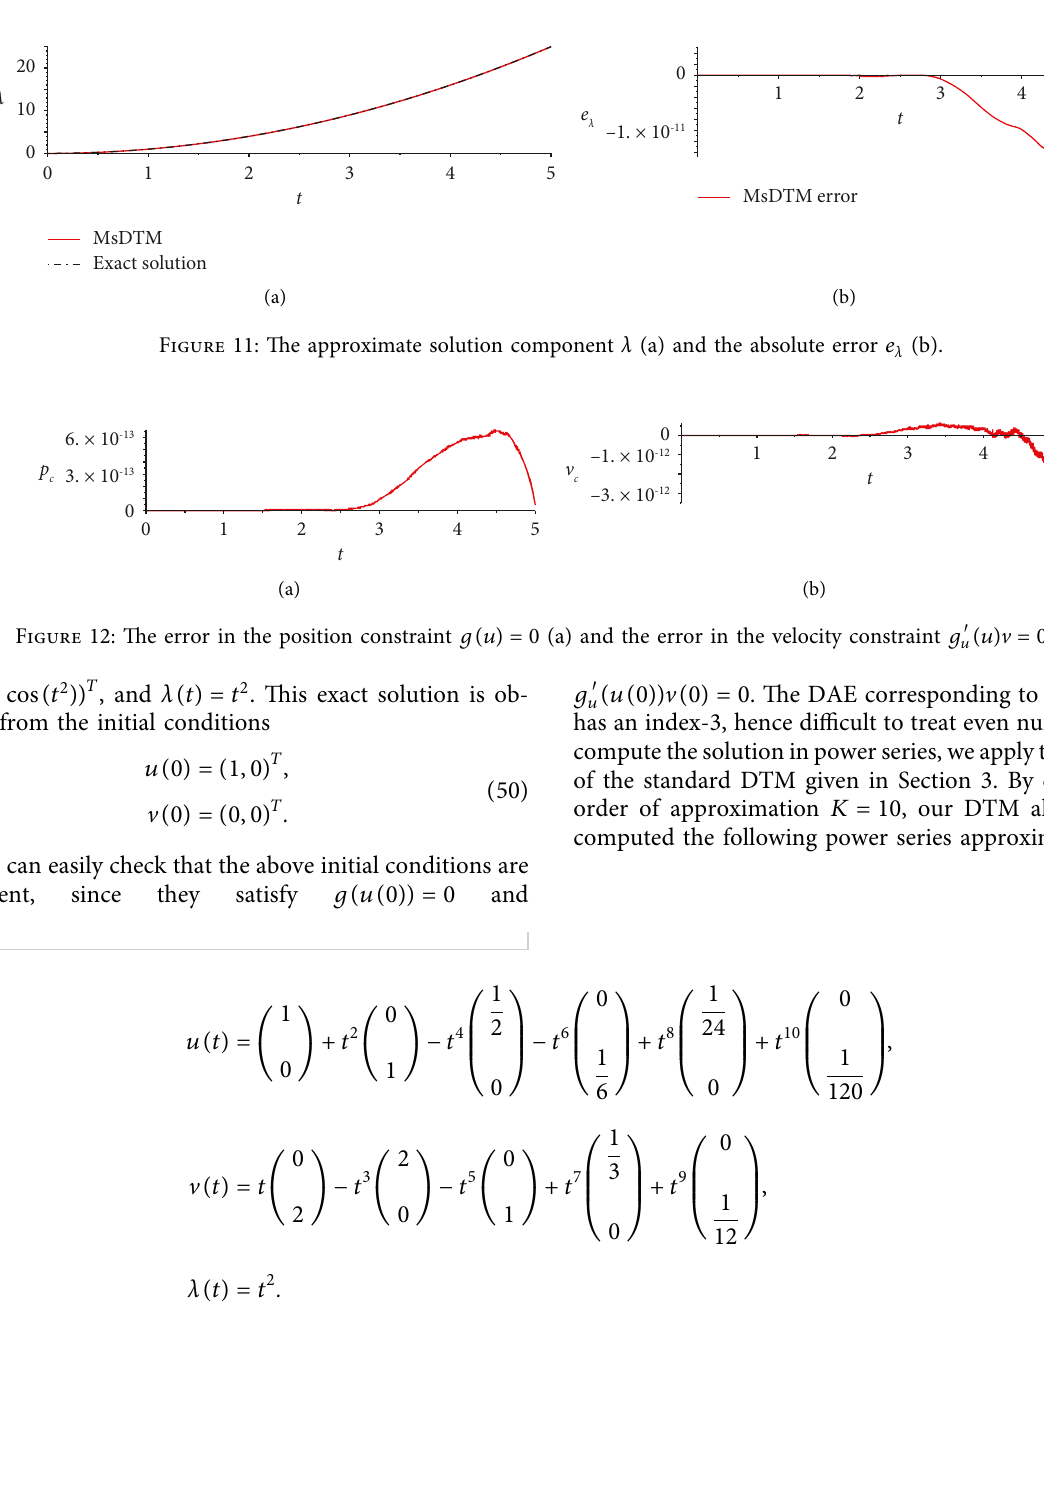
(a) and the absolute error e v 2